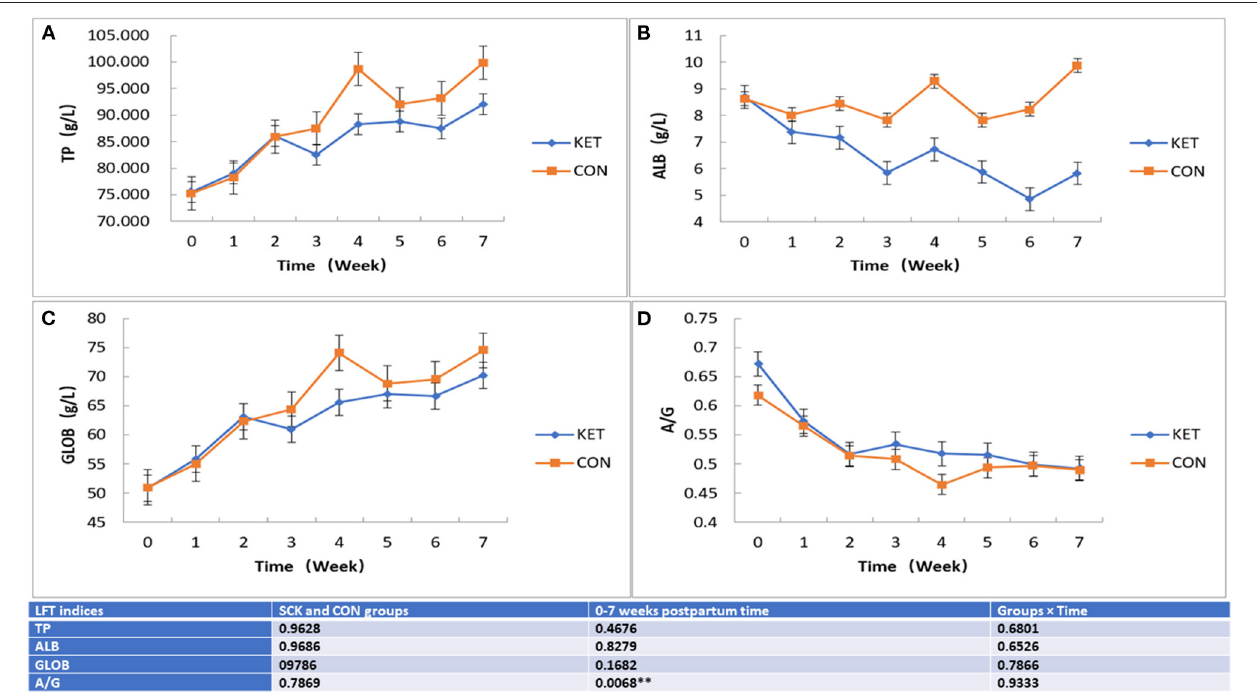
FIGURE 4 | The effect on TP, ALB, GLOB, and A/G (A-D) LFT indices in SCK and CON healthy cows monitored weekly eight times. (A) Effects of TP-LFT in SCK and CON healthy dairy cows monitored weekly eight times. (B) Effects of ALB-LFT in SCK and CON healthy dairy cows monitored weekly eight times. (C) Effects of GLOB-LFT in SCK and CON healthy dairy cows monitored weekly eight times. (D) Effects of A/G-LFT in SCK and CON healthy dairy cows monitored weekly eight times. **Denotes the difference is highly significant at p <